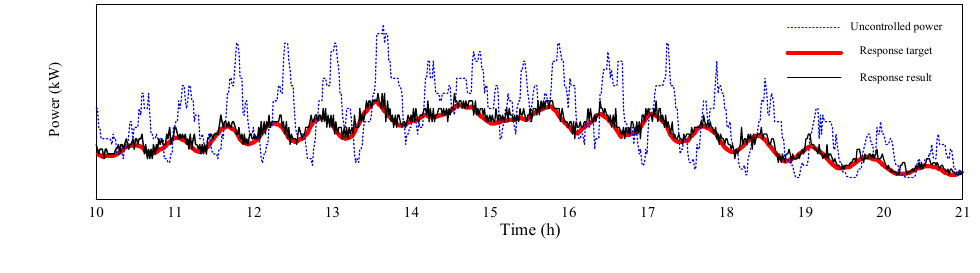
Figure 19. Response result of CAC.